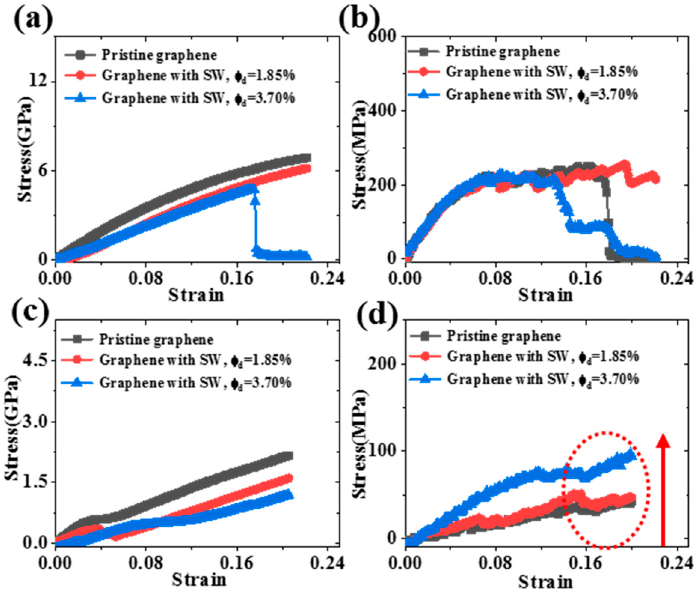
Figure 7. The stress-strain curves of nanocomposite with different concentrations of SW defect under ( a ) transverse tension, ( b ) longitudinal tension, ( c ) in-plane shear and ( d ) transverse shear. Table 5. The Young’s and shear modulus of nanocomposite with different concentrations of SW.